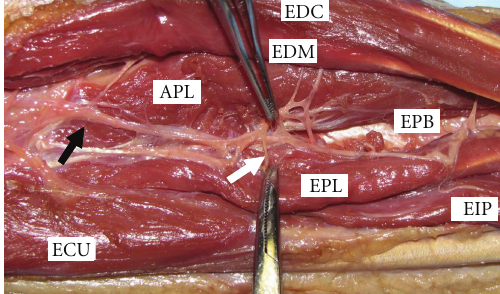
Figure 5: Cadaveric gross dissection of dorsal forearm. The extensor pollicis brevis (EPB), extensor digit minimi (EDM), extensor digitorum comunis (EDC), extensor carpi ulnaris (ECU), extensor pollicis longus (EPL), and extensor incidis proprius (EIP) are labeled. The black arrow indicates the posterior interosseous nerve after exiting the arcade of Frohse. The white arrow indicates a posterior interosseous nerve (PIN) branch to